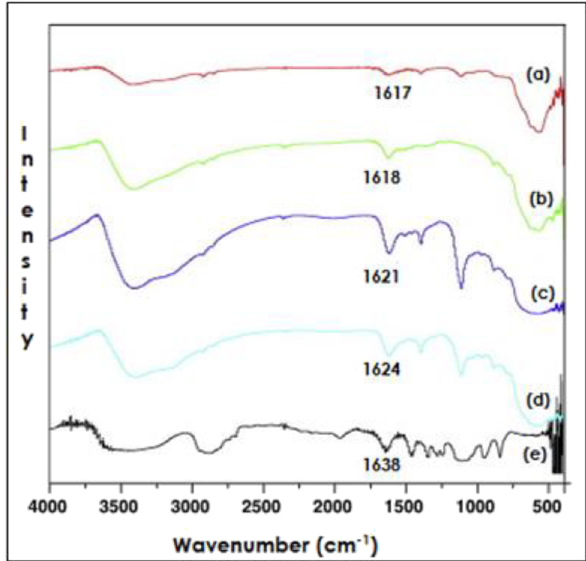
Figure 4: TEM images of AuNRs of di ff erent sizes [ 127 ] .